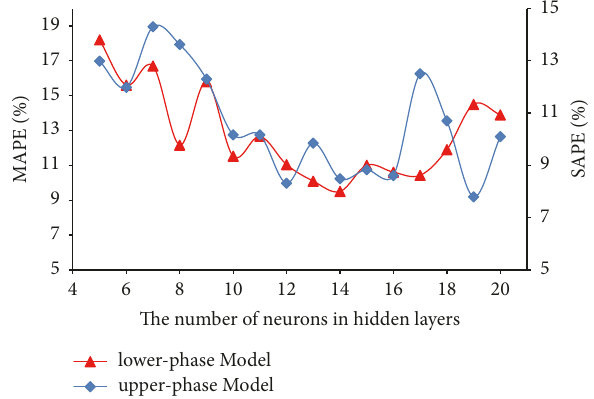
Figure 7: Relationship between MAPE/SAPE and the number of neurons on weekday.